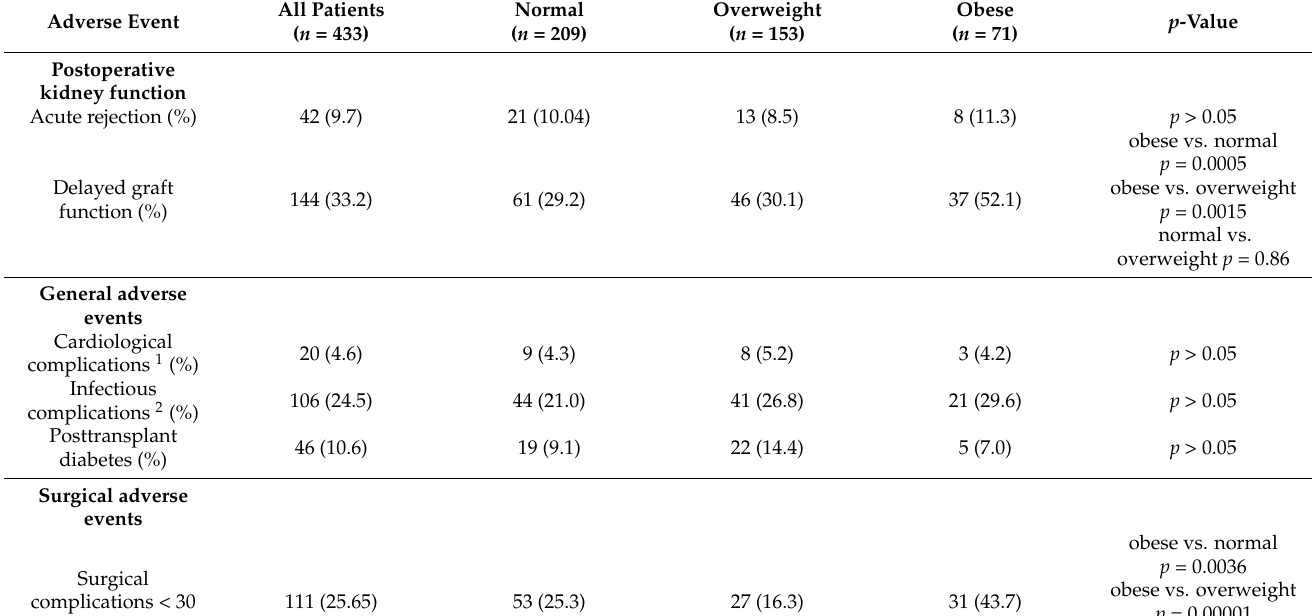
obese vs. normal p = 0.0036 obese vs. overweight p = 0.00001 normal vs. overweight p = 0.08